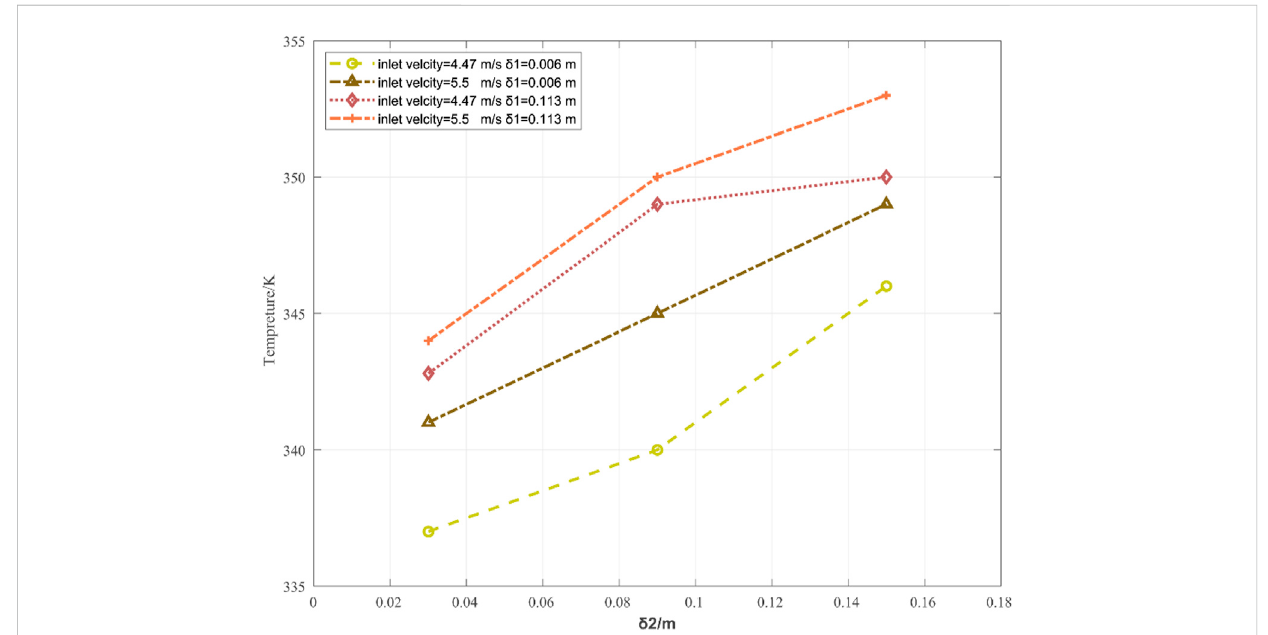
FIGURE 15 Lowestinstantaneoustemperatureobservedinthebatteryregionat2,400 sasafunctionof δ 2 fordifferentvaluesoftheinletair fl owvelocityand δ 1 .